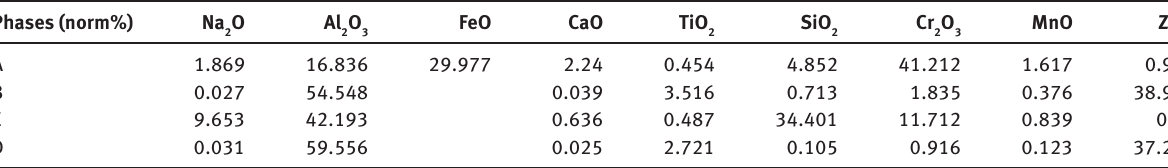
Table 5: Energy spectrum of